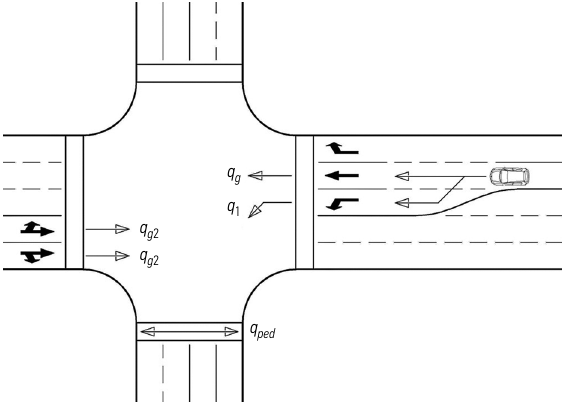
Fig. 2. Schemes of short traffic lanes commonly used in old towns of major cities: q g – transport that flows straight; q l – transport flow that turns left from the short traffic lane; q g 2 – opposite transport that flows straight; q ped – pedestrian flow in both directions (ped/h)